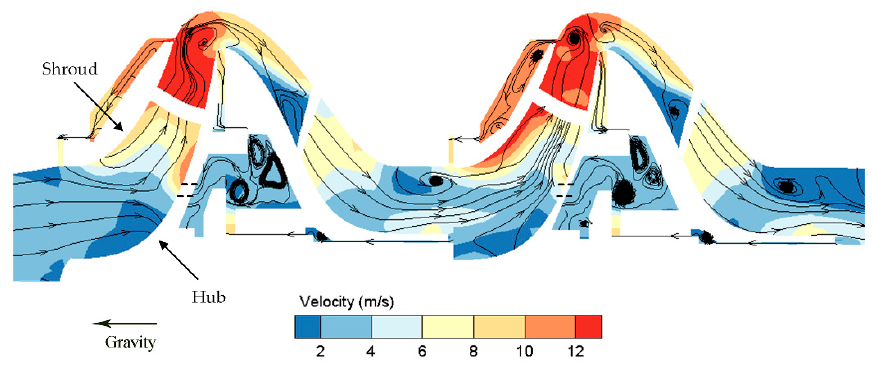
Figure 7. Velocity of continuous phase in shaft section at 1.2 s.